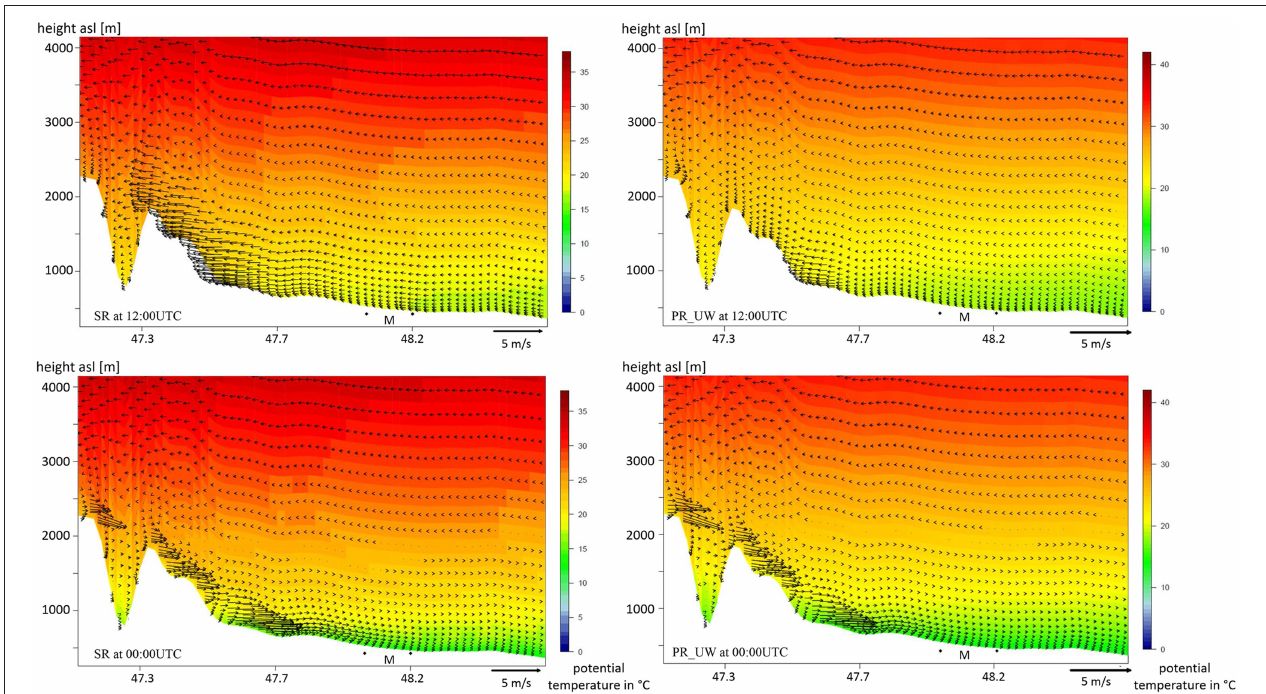
FIGURE 7 | Averaged v and w wind components along a meridional vertical cross section through Munich at 12:00 UTC (top) and 00:00 UTC (bottom) for the SR criterion (left) and PR_UW combination (right), with potential temperature shown by color shading in the background. The two black dots mark the northern and southern border of